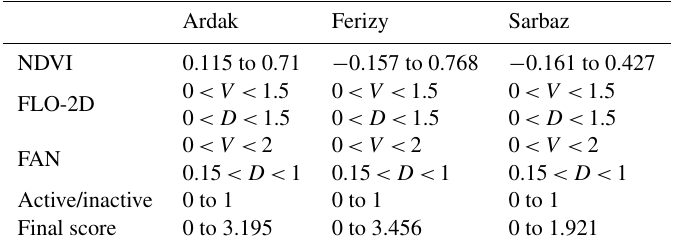
Table 4. Characteristics of three fans as regarding their flood hazard (velocity, V , and depth, D , are in ms − 1 and m, respectively).